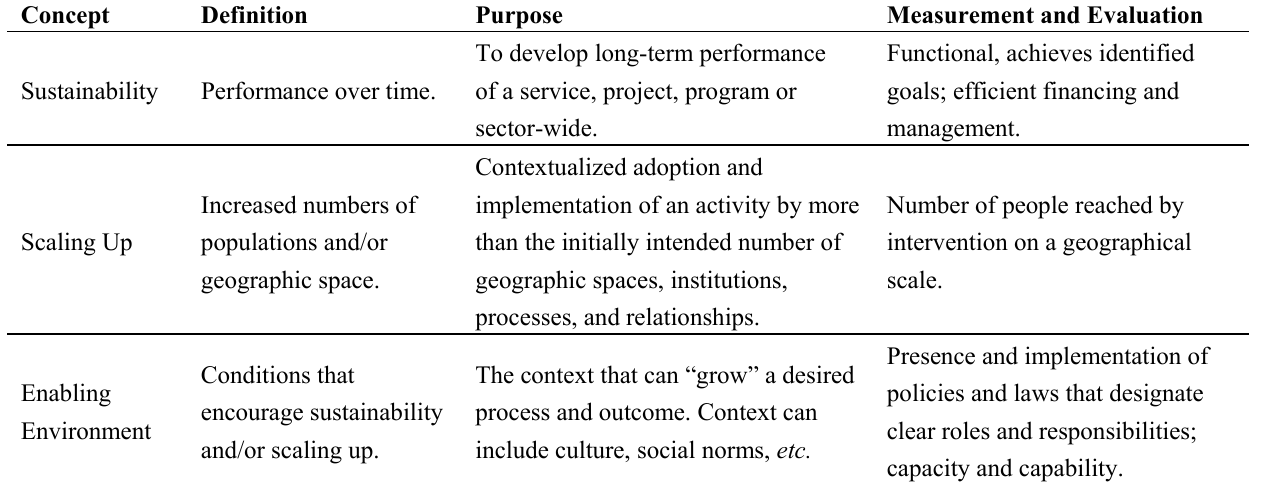
Table 2. Sustainability, scaling up, and enabling environment definition and